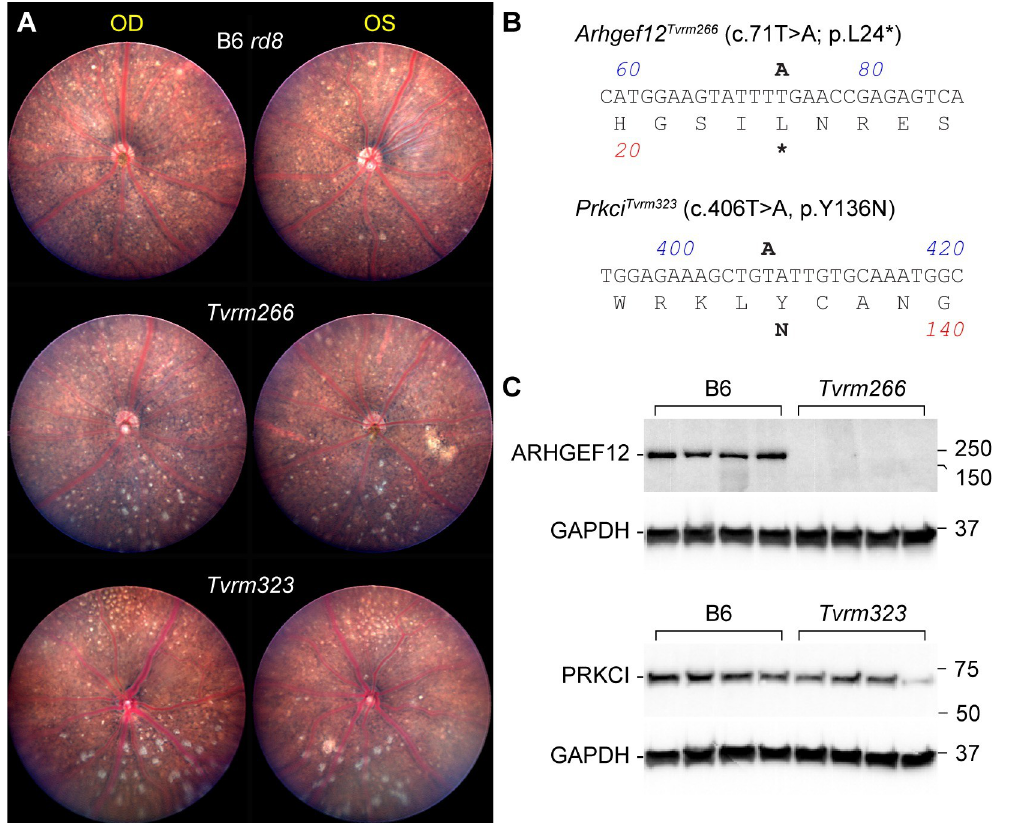
Fig 2. Identification of mutations and protein expression in modifier strains. A. Fundus photodocumentation of B6 rd8 and Tvrm266 mice at 10 weeks of age, and Tvrm323 mice at 3 months of age. Right (OD) and left (OS) eyes of a single mouse are shown. The lower portion of each image corresponds to the inferior retina based on the position of the mouse head relative to the camera during imaging. B. Sequence and amino acid translation of the mutant alleles. The DNA sequence corresponds to a portion of the forward strand of each gene, numbered as in the mRNA. Mutations are indicated in bold above the sequence. The predicted amino acid sequence is given beneath the DNA sequence using the single-letter code and the predicted translational effect of the mutation is indicated in bold below. C. Enhanced chemiluminescence western analysis. Posterior eyecup lysates from B6 control and modifier strains (n = 4) were electrophoresed and transferred to nitrocellulose. Tvrm266 blots were probed with ARHGEF12 antibody and Tvrm323 blots with PRKCI antibody. After imaging, blots were probed with GAPDH antibody and reimaged to control for protein recovery and loading. Molecular weights of protein standards are indicated in